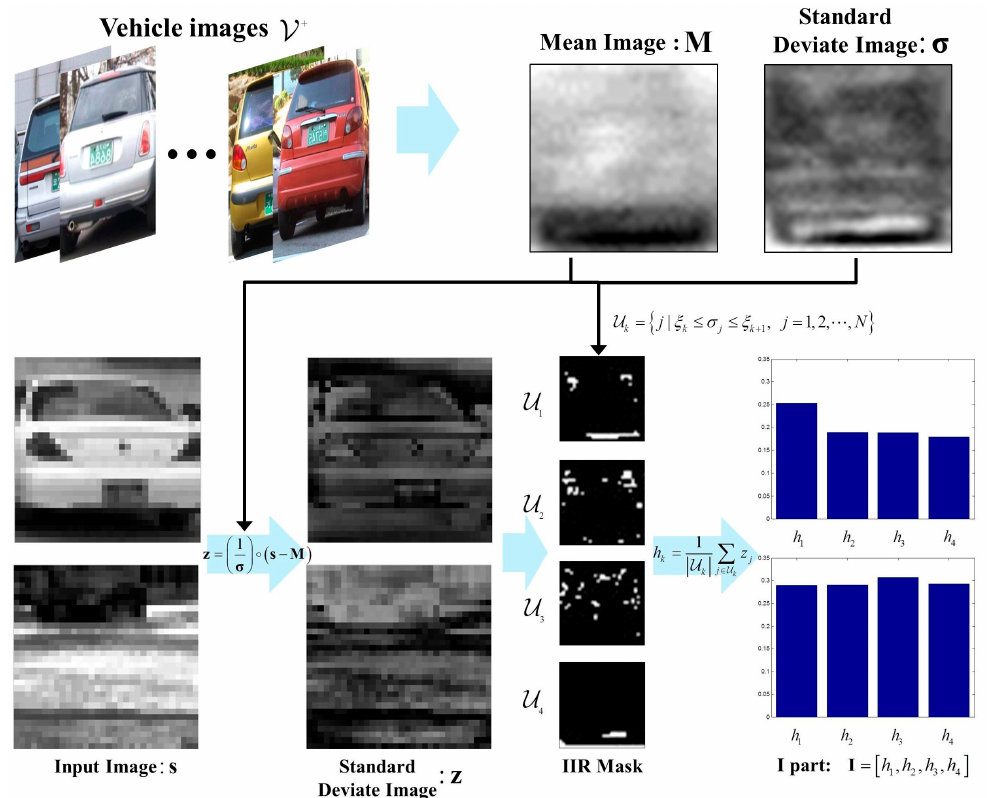
Figure 1. Examples of computing I part using 4 IIR masks [16].